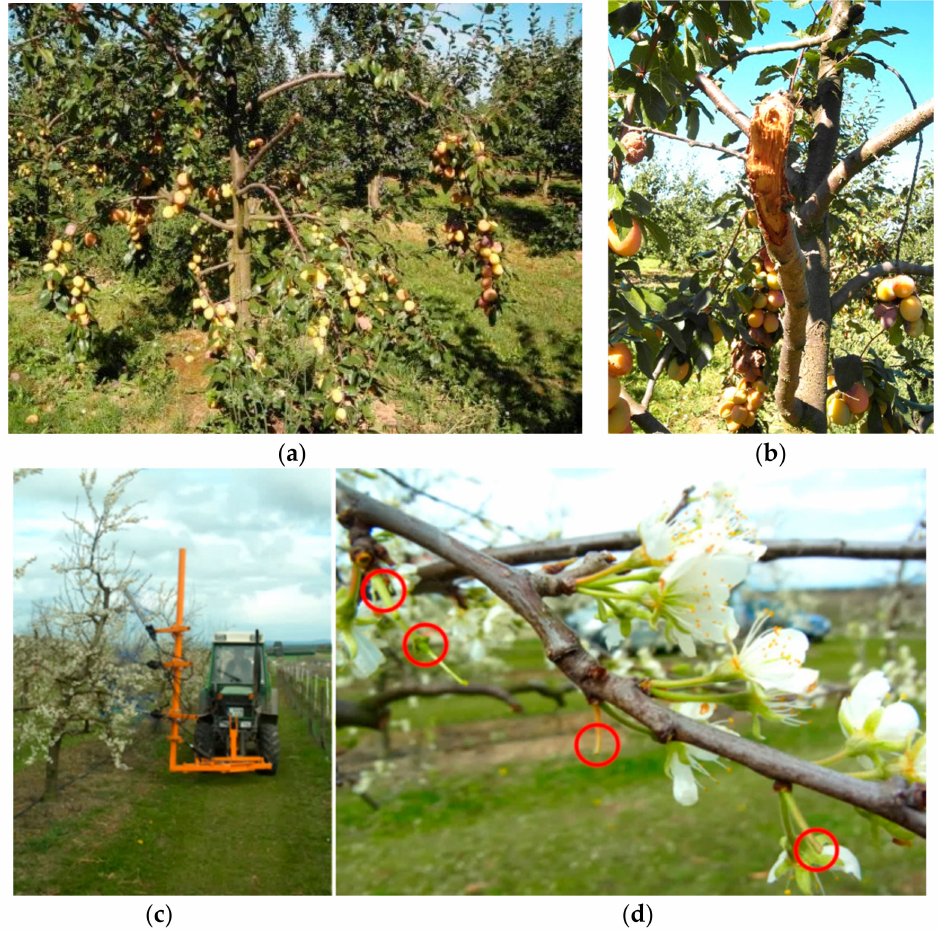
Figure 1. ( a ) Overloaded plum tree (top left), ( b ) which can lead to branch breakage (top right); ( c ) mechanical thinning in plum cv. “Ortenauer”, using the Bonner thinning device (‘BAUM’) with three rotors and adapted to the spindle tree (bottom left); and ( d ) individual flowers mechanically removed from the branch (red circles, bottom right) in a commercial orchard near Bonn (Photos © M. Blanke,